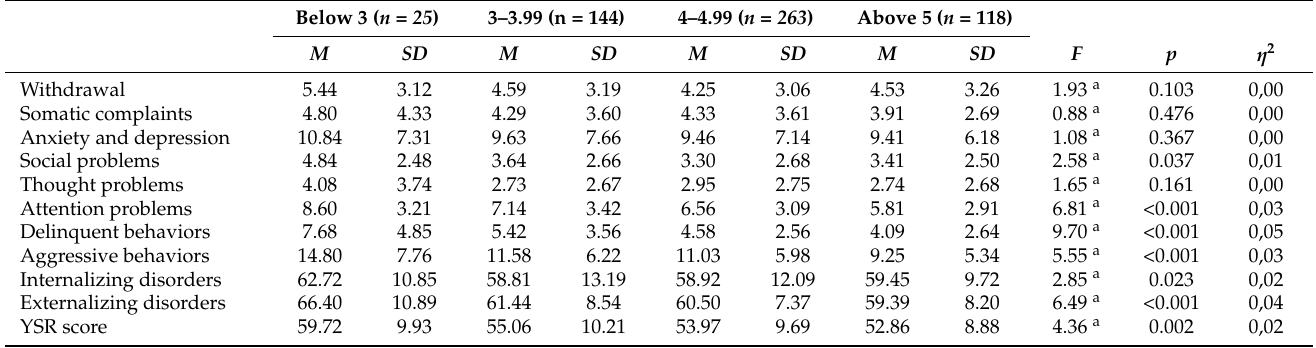
Table 5. Youth Self Report scale scores for students with different grade averages.